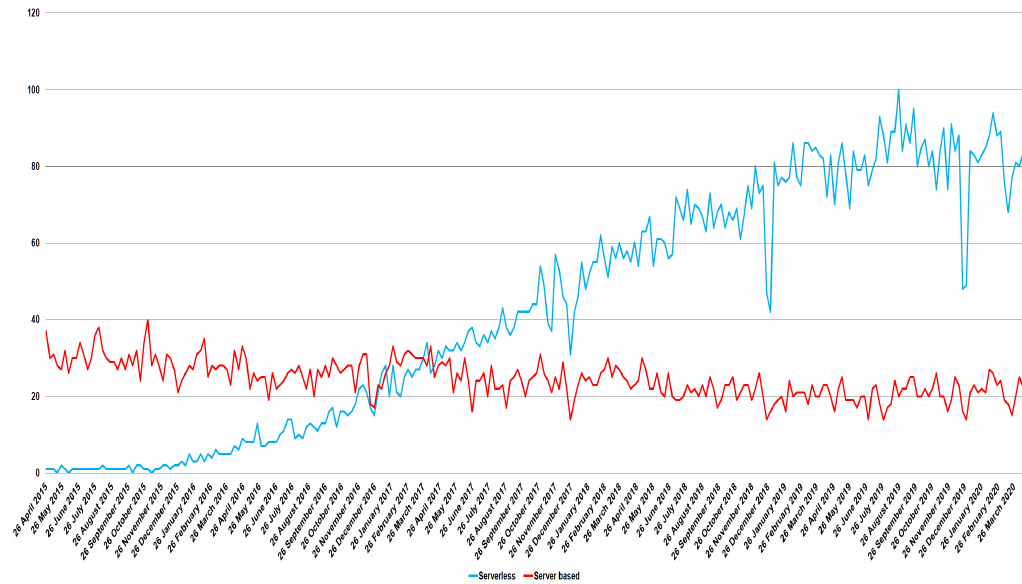
Figure 3. Trade-offs between serverless and server-based approach obtained from Google Trends.